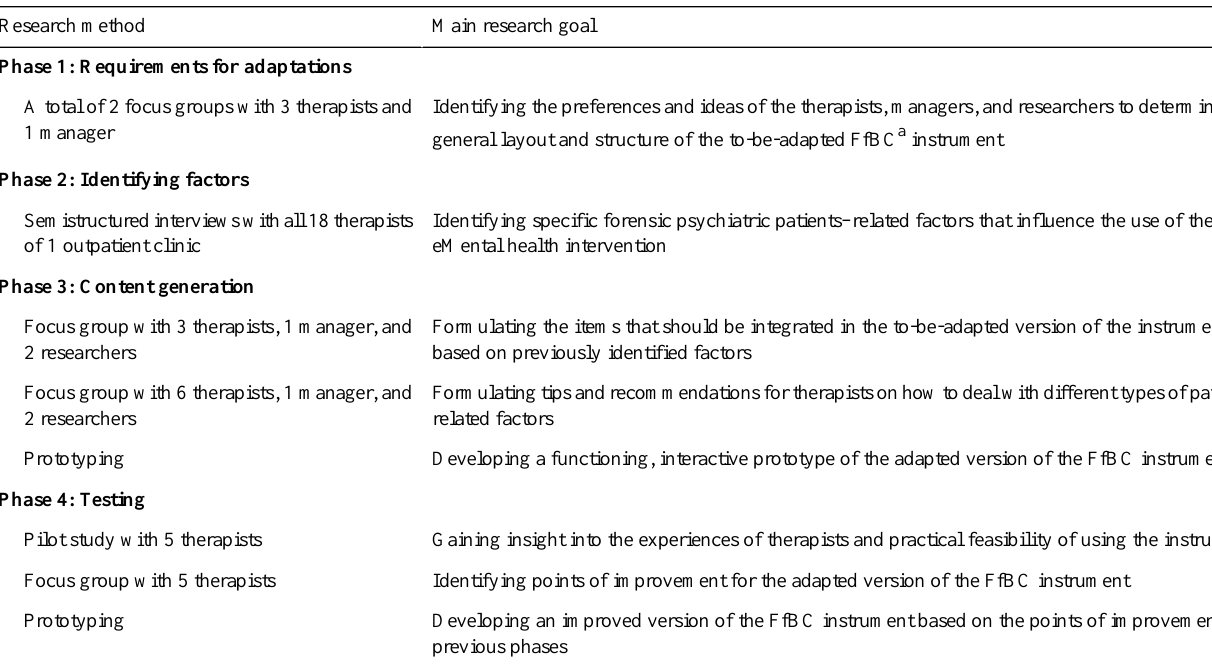
Table 2. An overview of the methods used to adapt the Fit for Blended Care instrument for forensic mental health